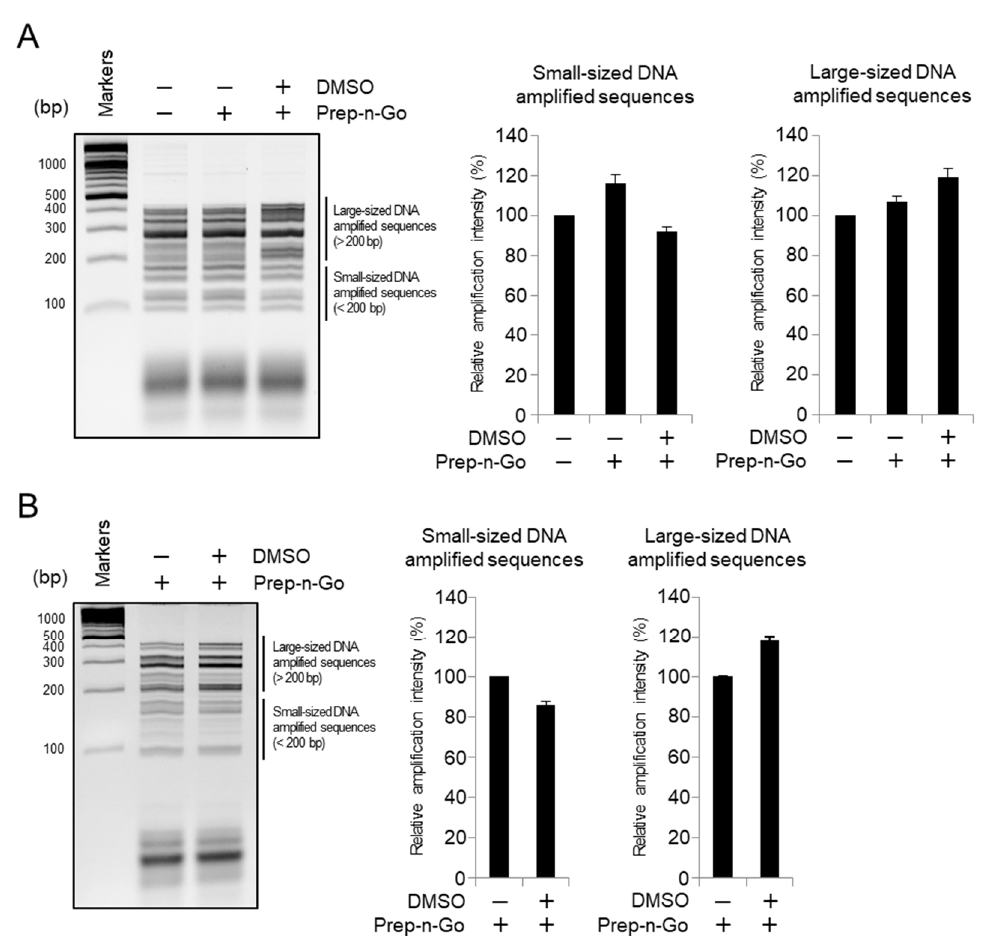
Figure 2. Effect of dimethyl sulfoxide (DMSO) in direct PCR performed using the GlobalFiler kit with Prep-n-Go buffer (2 µL/25 µL PCR reaction volume). Amplification yield with DMSO examined in 2800M DNA ( A ) and 1.2 mm-punched saliva samples ( B ) and compared in each of small- and large-sized DNA amplified sequences. Intensity of amplified PCR product was measured by Image J software.